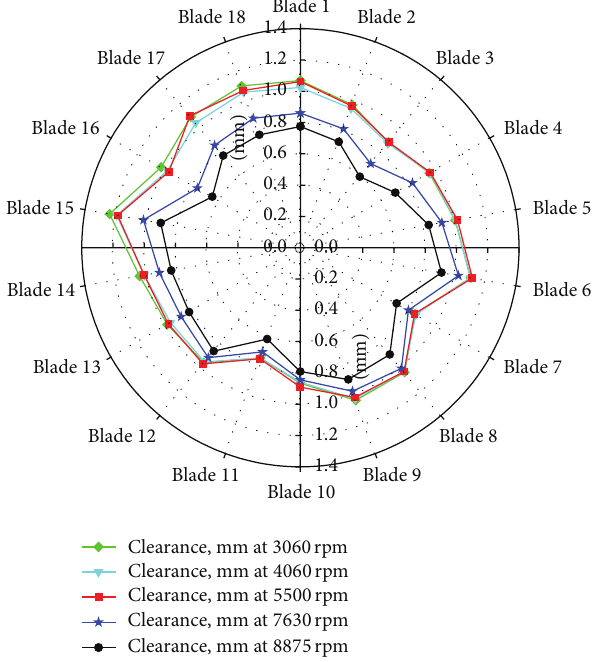
Figure 4: Blade tip clearance polar plot for probe #1, 90 ∘ location— NASA Turbofan experiment.